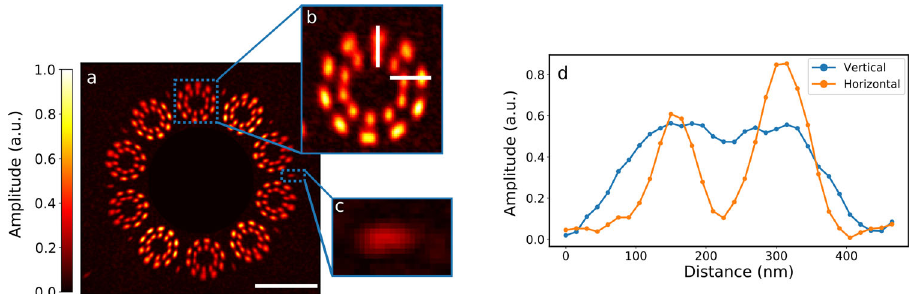
Fig. 2 Broadband Fourier transform holography. a Fourier transform of the measured hologram shown in Fig. 1d. The intense autocorrelation in the center is blocked and only the fi ve cross-correlation terms and their corresponding complex-conjugates are shown. The scale bar represents 1.5 µ m. b A magni fi ed version of the top cross-correlation. c A magni fi ed version of a smeared cross-correlation of two reference apertures. d The vertical and horizontal lineouts indicated in b . The amplitude is given in arbitrary